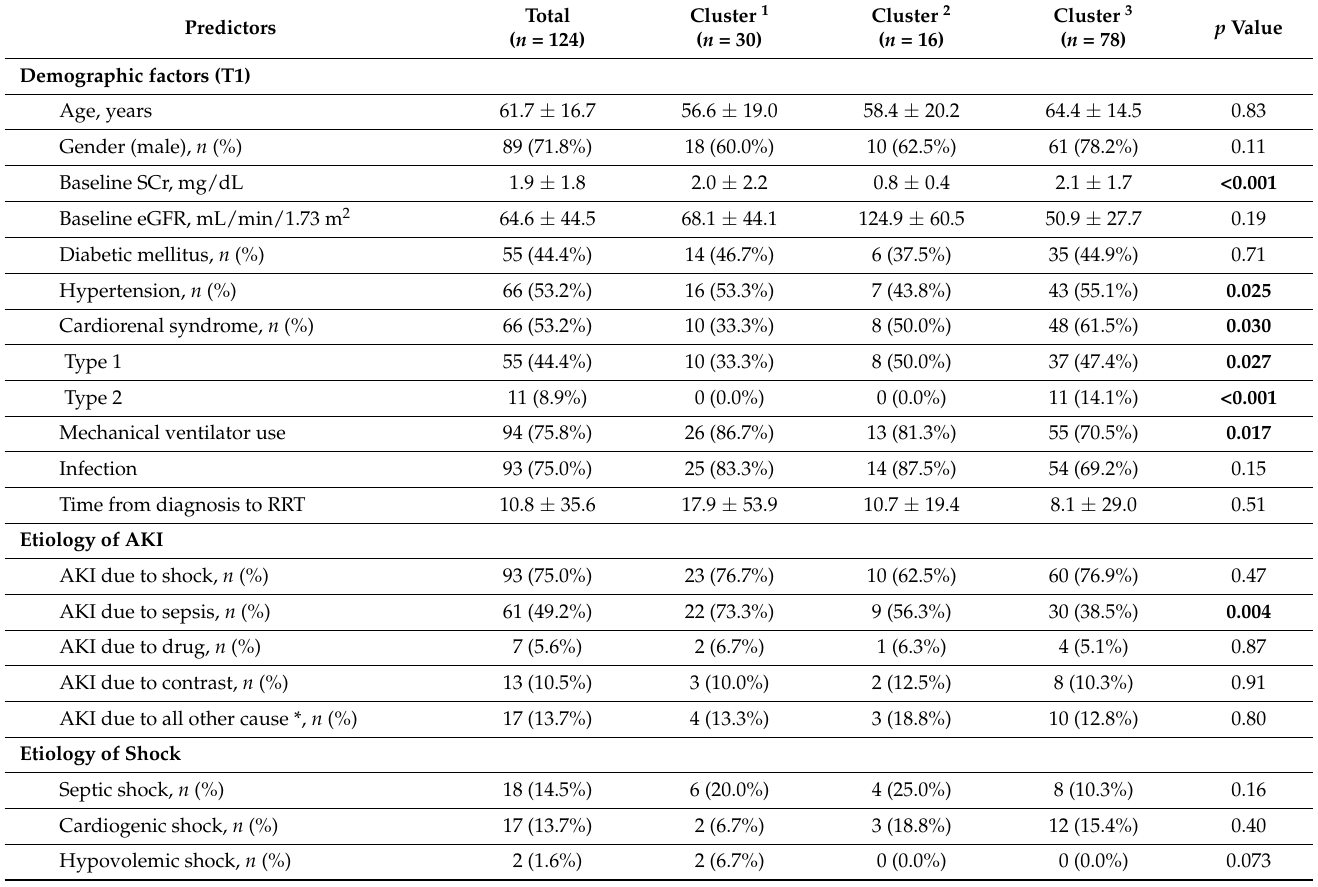
Table 1. Characteristics of enrolled